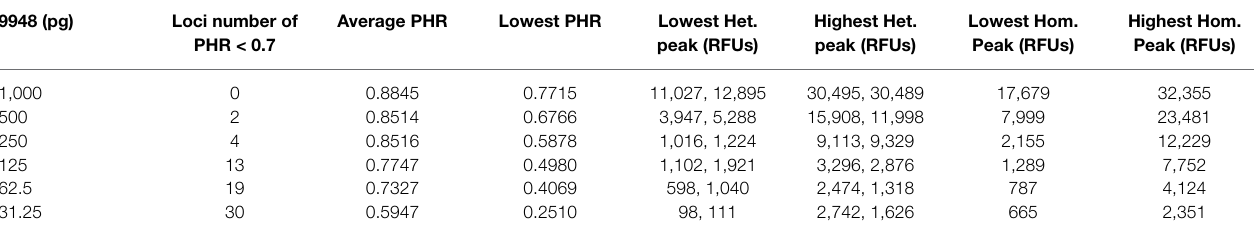
PHR, peak height ratio; Het, heterozygous; Hom,